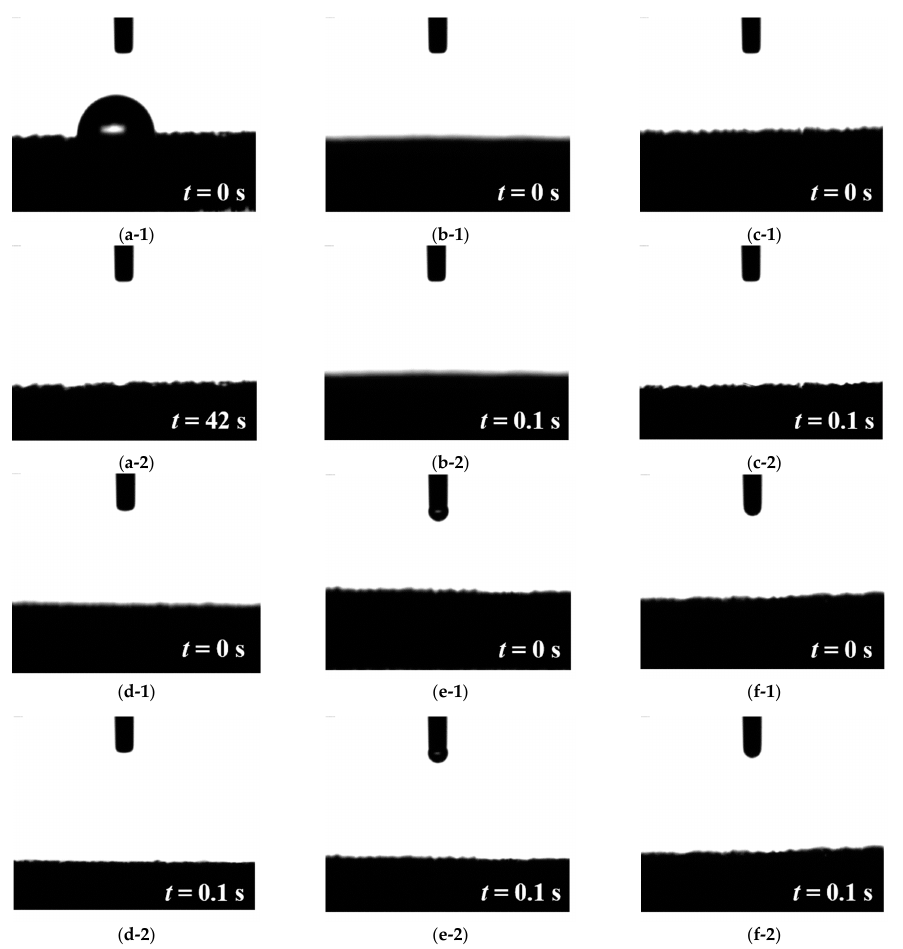
Figure 1. Water contact angles of ( a-1 ) pristine NF right after the droplet was dispensed, ( a-2 ) pristine NF after the droplet was dispensed for 42 s, ( b-1 ) NF* right after the droplet was dispensed, ( b-2 ) NF* after the droplet was dispensed for 0.1 s, ( c-1 ) Ru/NF* right after the droplet was dispensed, ( c-2 ) Ru/NF* after the droplet was dispensed for 0.1 s, ( d-1 ) Ru/NF*-A right after the droplet was dispensed, ( d-2 ) NF*-A after the droplet was dispensed for 0.1 s, ( e-1 ) Ru/NF*-AH right after the droplet was dispensed, and ( e-2 ) Ru/NF*-HO after the droplet was dispensed for 0.1 s; ( f-1 ) Ru/NF*-AO right after the droplet was dispensed, and ( f-2 ) Ru/NF*-AO after the droplet was dispensed for 0.1 s.